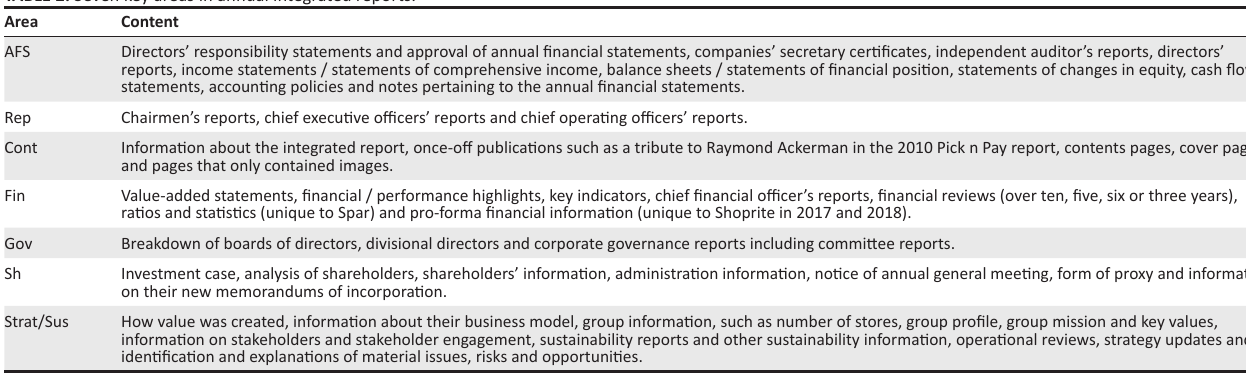
TABLE 2: Seven key areas in annual integrated